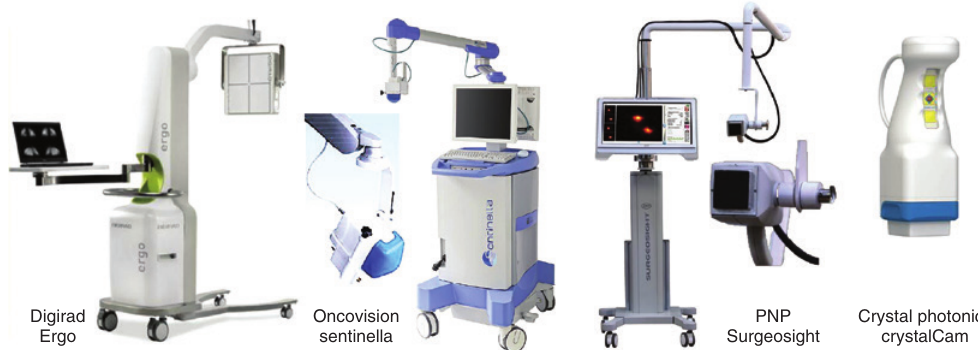
Figure 6: Portable and handheld commercial gamma cameras for intraoperative use. Reproduced with permission from